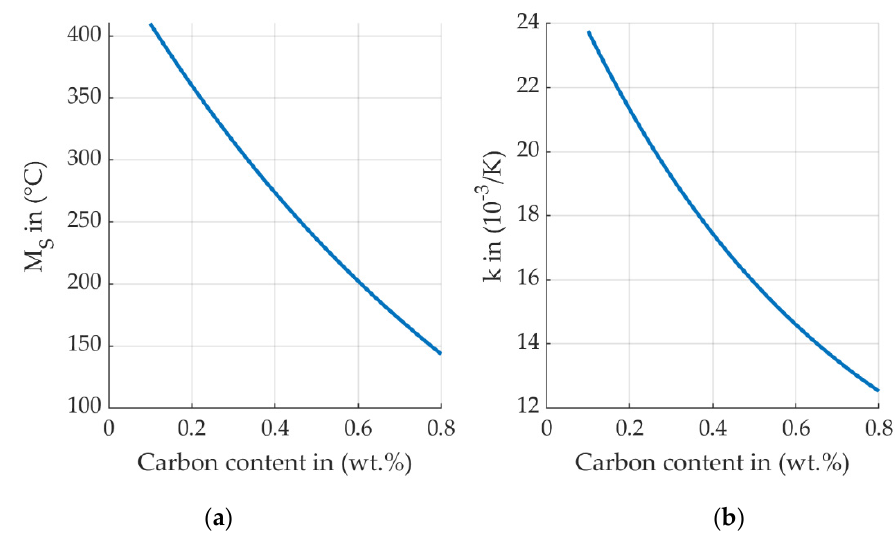
Figure 1. ( a ) Calculated martensite start temperature and ( b ) parameter k of the Koistinen-Marburger equation for steel S156.